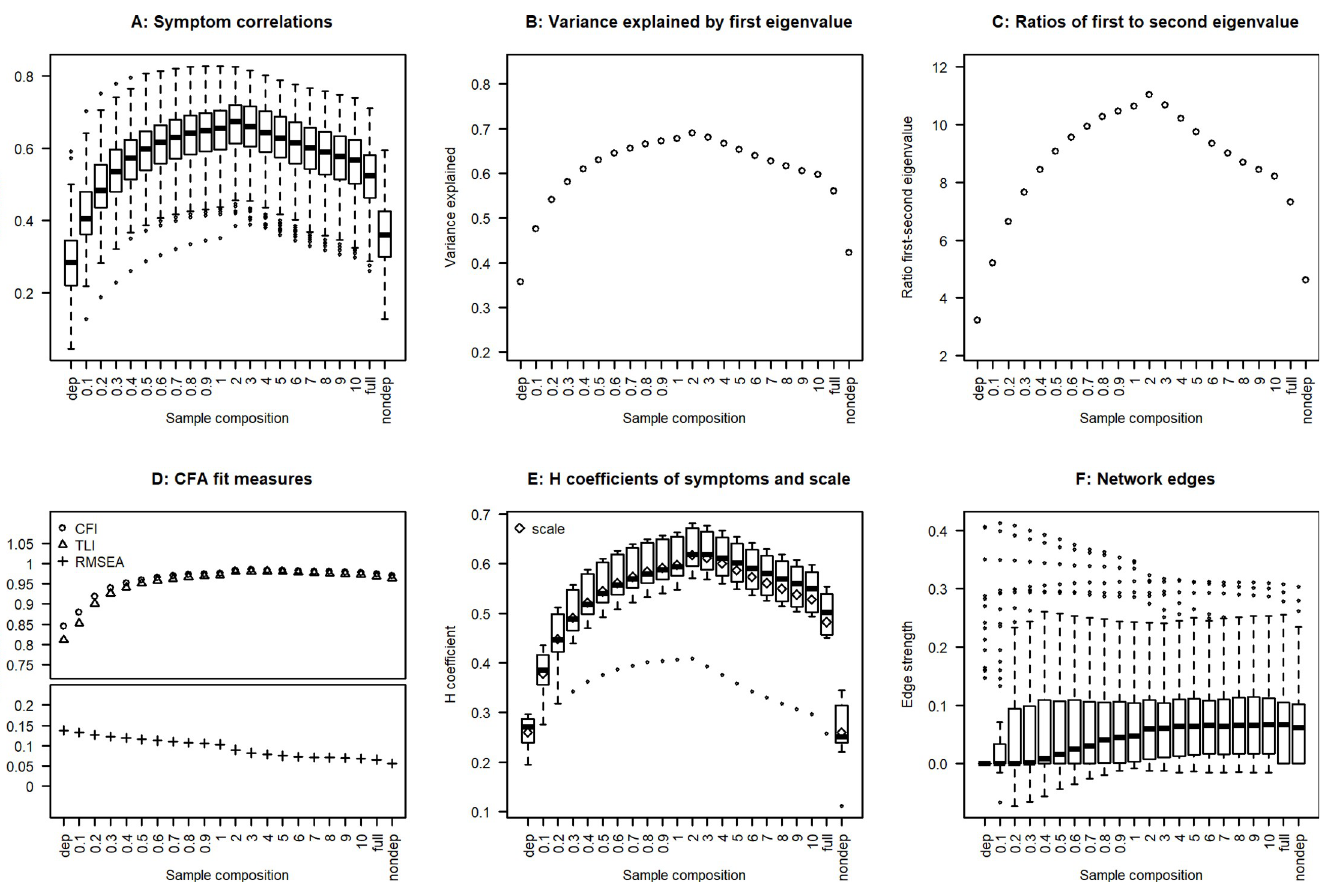
Fig 1. Correlations, dimensionality, scalability, and network edges of depression symptoms in function of the proportion of non-depressed participants in the study sample. A shows the correlations of the symptoms. B-C show the results of a principal component analysis. D shows the fit indices of a confirmatory one-factor analysis. E shows the scalability coefficient H for both the individual symptoms and the scale made up of all symptoms. F shows the edges of the symptom network. Abbreviations: dep: Depressed subjects only; full: General population sample, nondep: Non-depressed subjects only; CFA: Confirmatory Factor Analysis; CFI: Comparative Fit Index; TLI: Tucker-Lewis Index; RMSEA: Root Mean Square Error of Approximation.